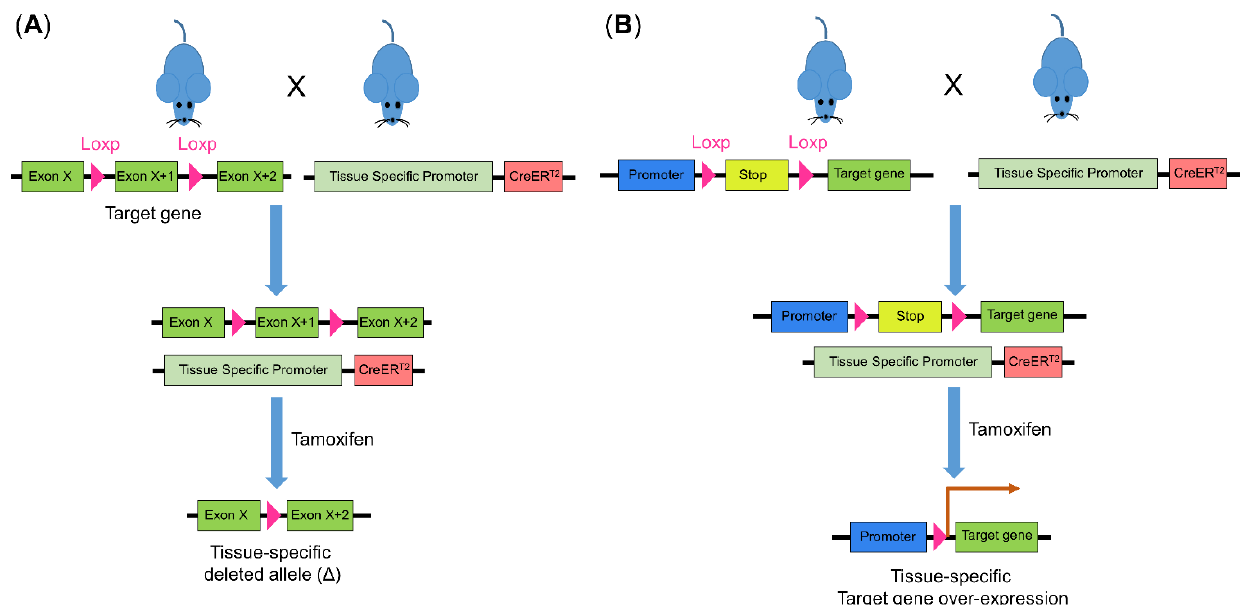
Figure 4. Cre-Loxp recombination system for genetic modulation in mice. The introduction of Loxp to flank the target gene creates a conditional knock-out prerequisite. Mice with the introduced Loxp is inter-crossed with mice carrying Cre whose promoter is tissue specific. Using tamoxifen, Cre is activated and ( A ) leads to target gene deletion or ( B ) deletion of the stop motif and subsequent overexpression of the target gene. Cre, Cre recombinase.